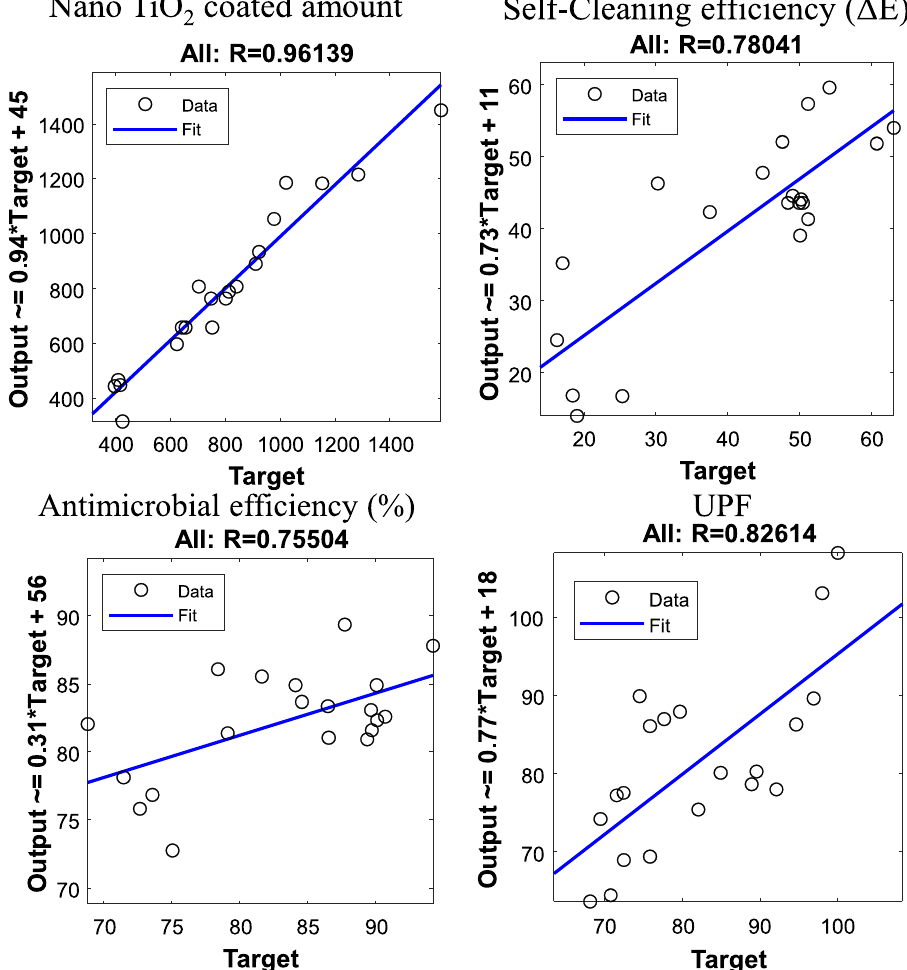
Figure 7. Correlation between the predicted and actual values using MLR model.